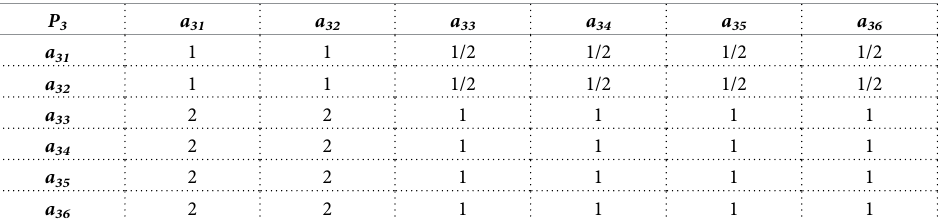
{ a , a , a , a }. 31 32 33 34